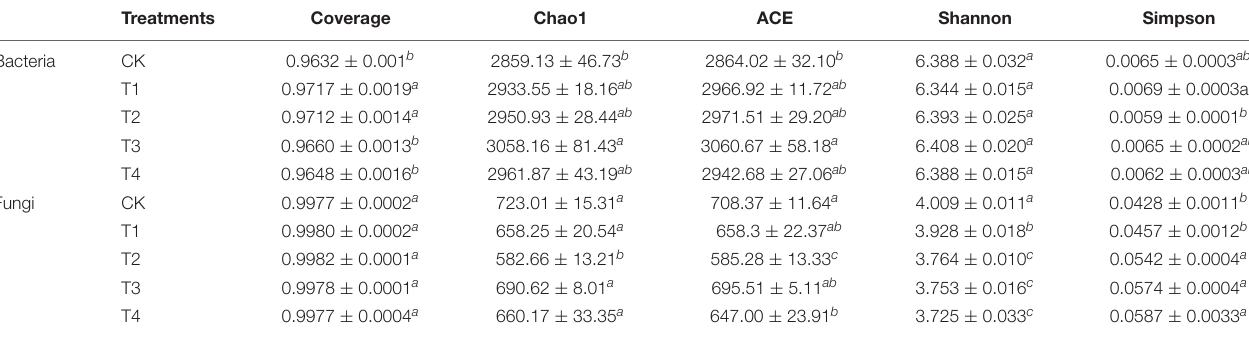
TABLE 2 | Alpha diversity indices of soil bacteria and fungi in different fertilization treatments.